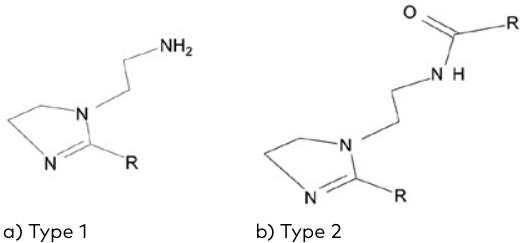
Figure 3. The structural formula of imidazoline (Bajpai & Tyagi,